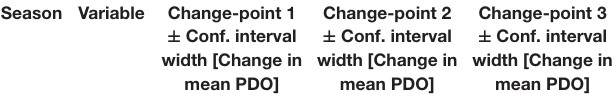
TABLE 2 | Change-points in mean for PDO with: PELT change-point estimate ± width of approximate 95% confidence interval (when change detection test p -value < 0.05) and [amount of change in mean PDO], or only PELT change-point estimate (when change detection test p -value > 0.05). Season Variable Change-point 1 ± Conf. interval